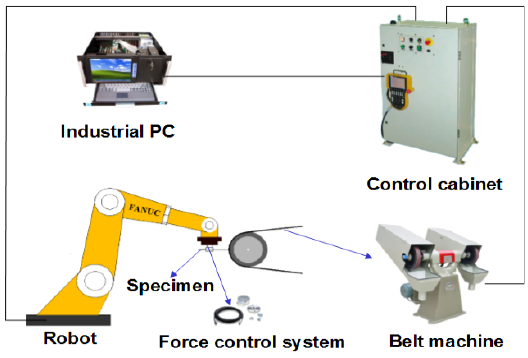
Figure 1. Schematic diagram of experimental setup.